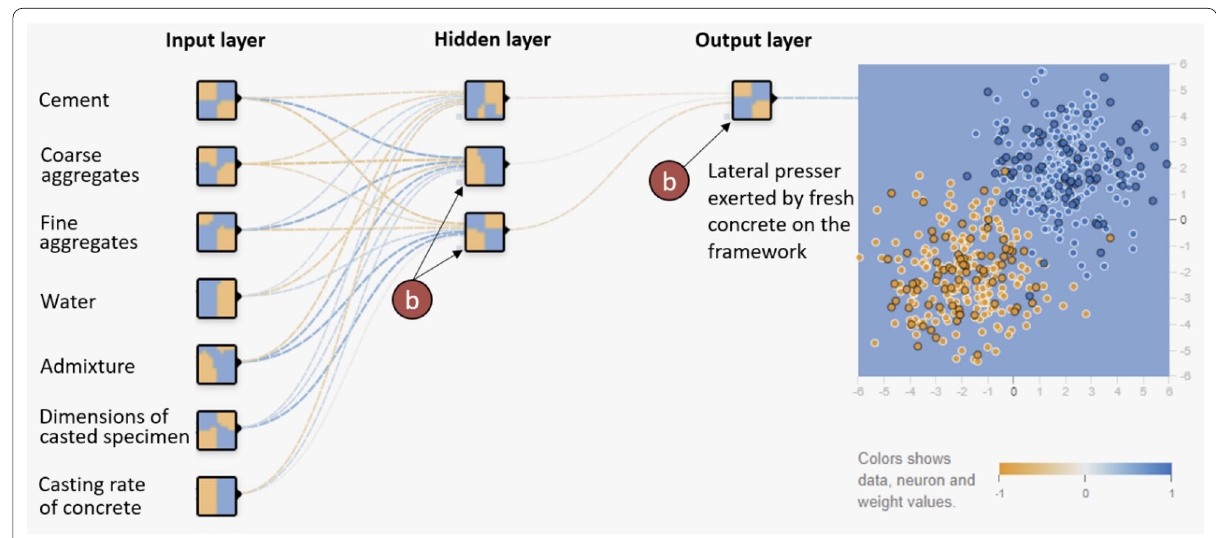
Fig. 7 An illustrative of